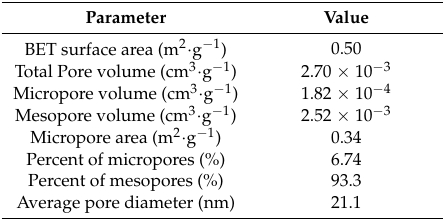
Table 2. Pore characteristics of YTBS